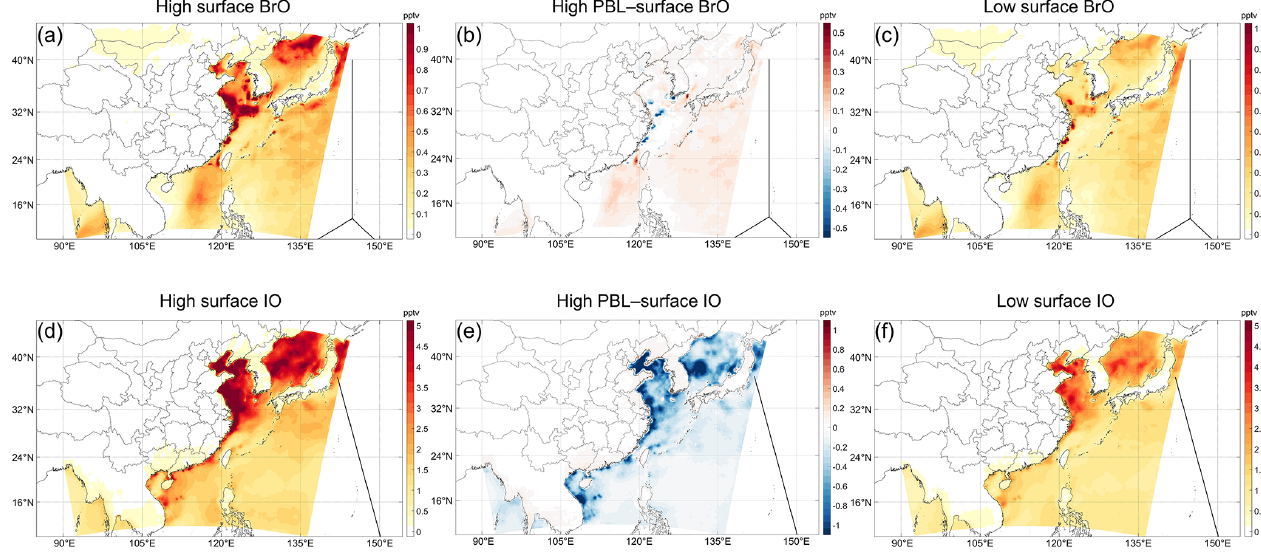
Figure 1. Daytime (local time 08:00–16:00) average of (a) surface BrO, (b) difference between planetary boundary layer (PBL) and surface BrO for a high emission rate, and (c) surface BrO for a low emission rate. Panels (d) – (f) are for IO. The black lines indicate roughly the trajectories of flights or cruises in previous studies reporting relevant measurements (see Table 3). Table 3. Comparison of BrO and IO in the Philippine Sea in our simulations (surface layer) with observations and simulations reported in other